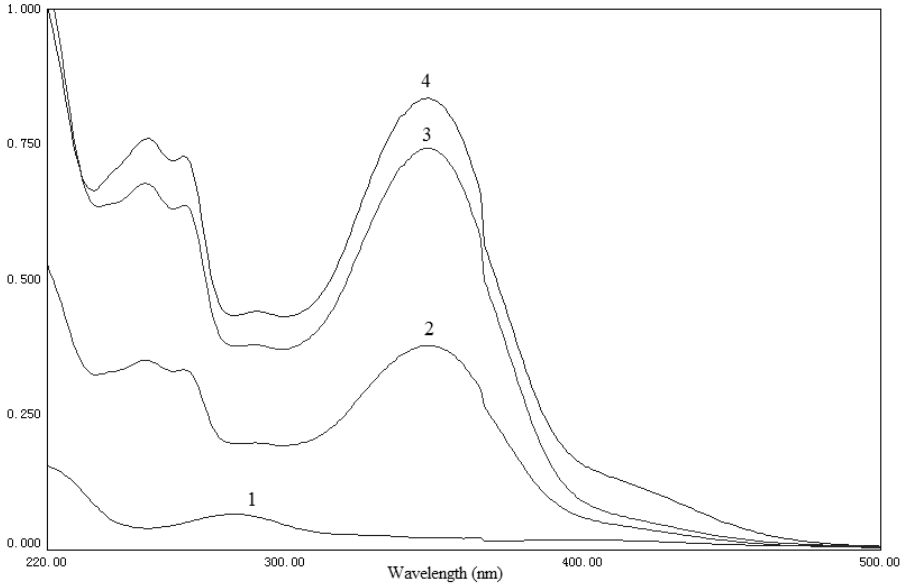
Figure 2. UV spectra of phospholipid (1), physical mixture of luteolin and phospholipid